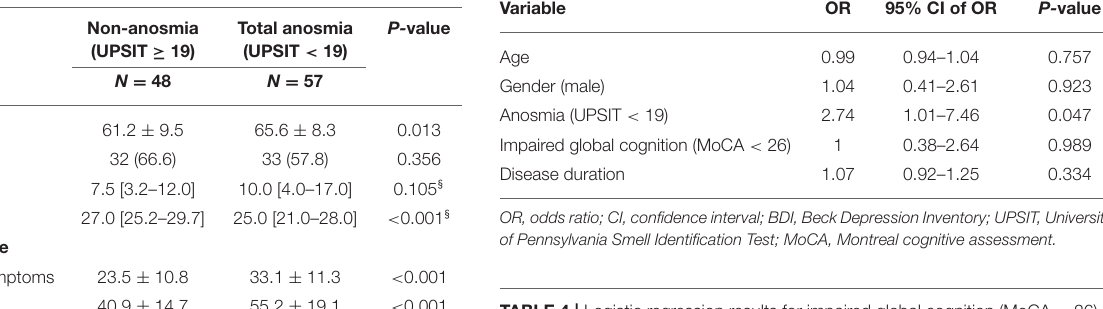
TABLE 4 | Logistic regression results for impaired global cognition (MoCA <